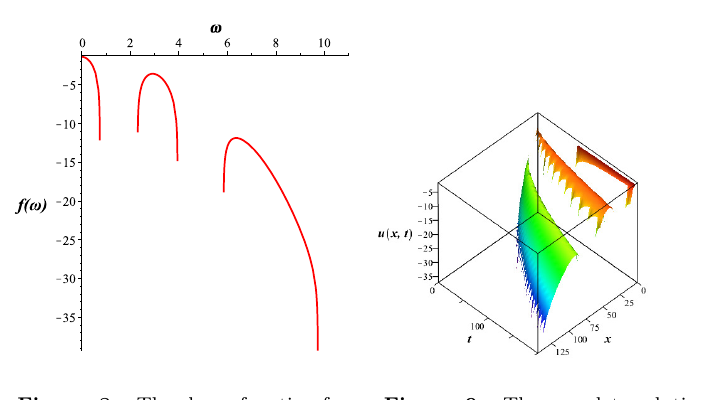
Figure 9. The complete solution for the white noise for a = 1 / 2 ,λ = 2, ν = 1 / 2 and for c 1 = c 2 = 1